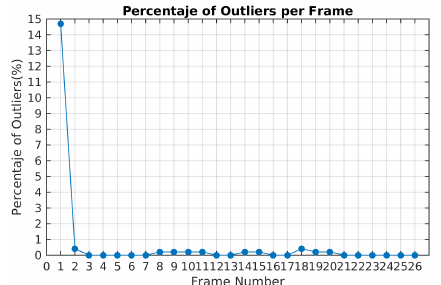
Figure 9. Ratio of outliers using TbD-SfM method for Scene 3.